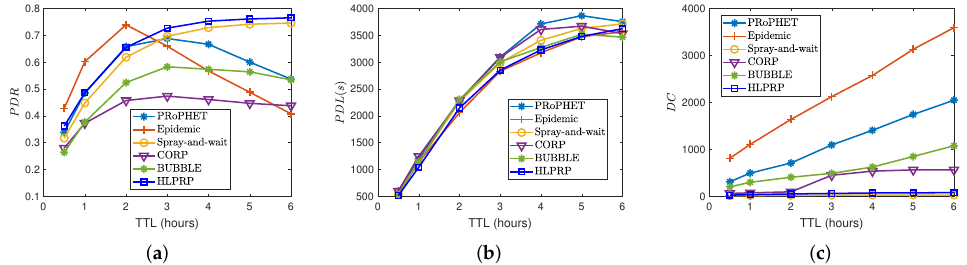
Figure 4. The network performance for various values of packet time to live. ( a ) PDR . ( b ) PDL . ( c ) DC